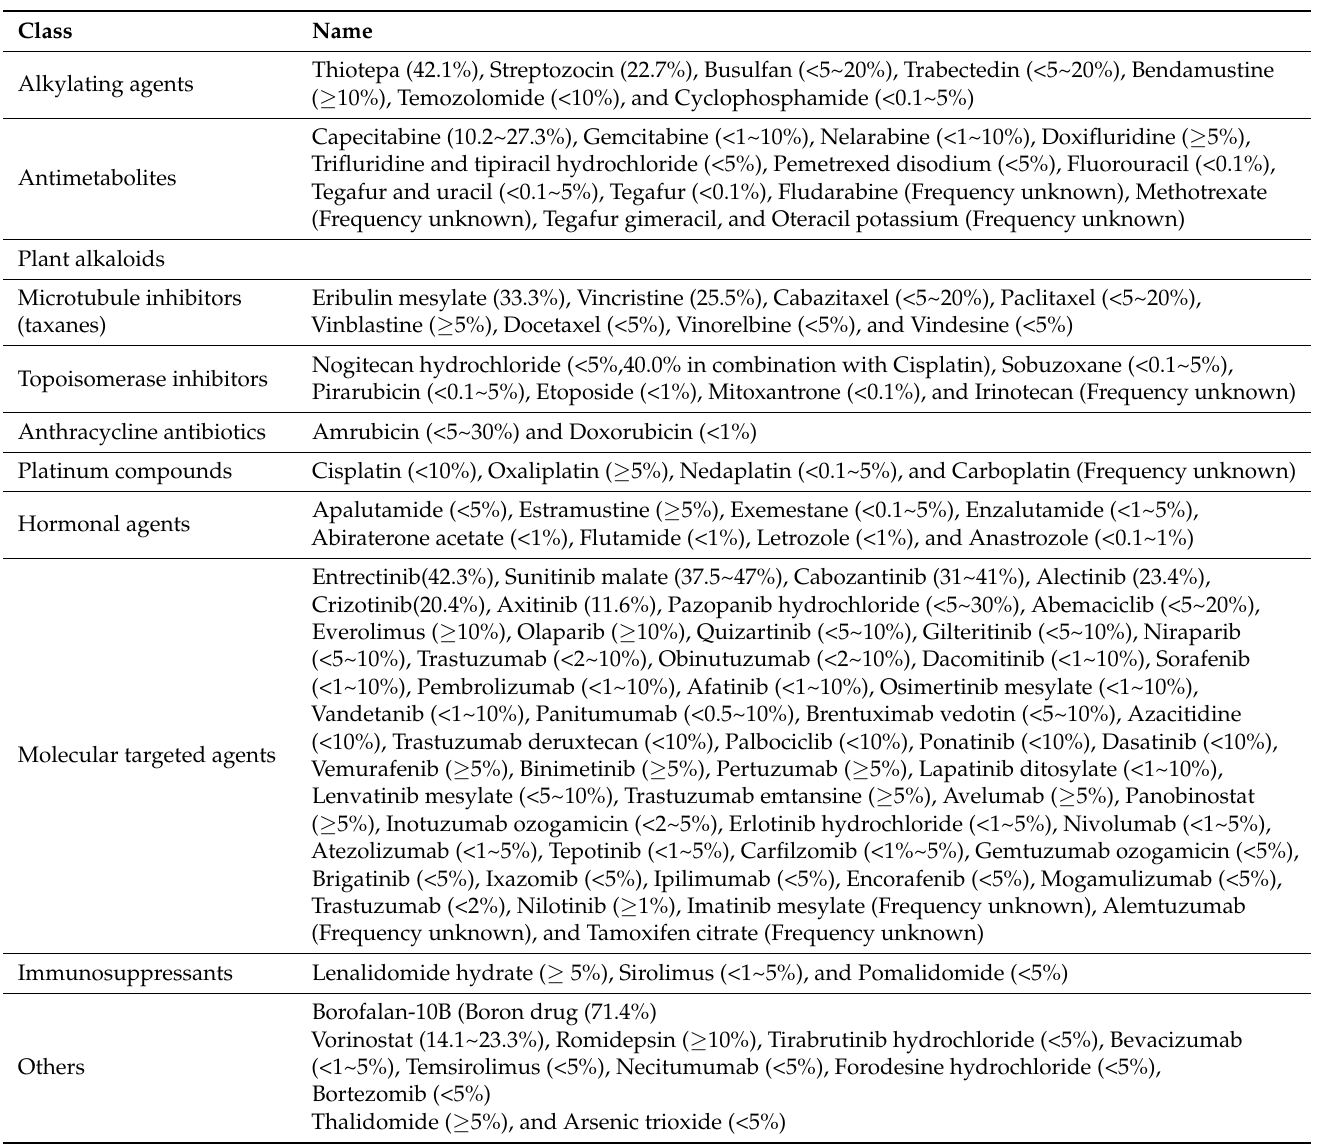
Table 2. Antineoplastics that can cause